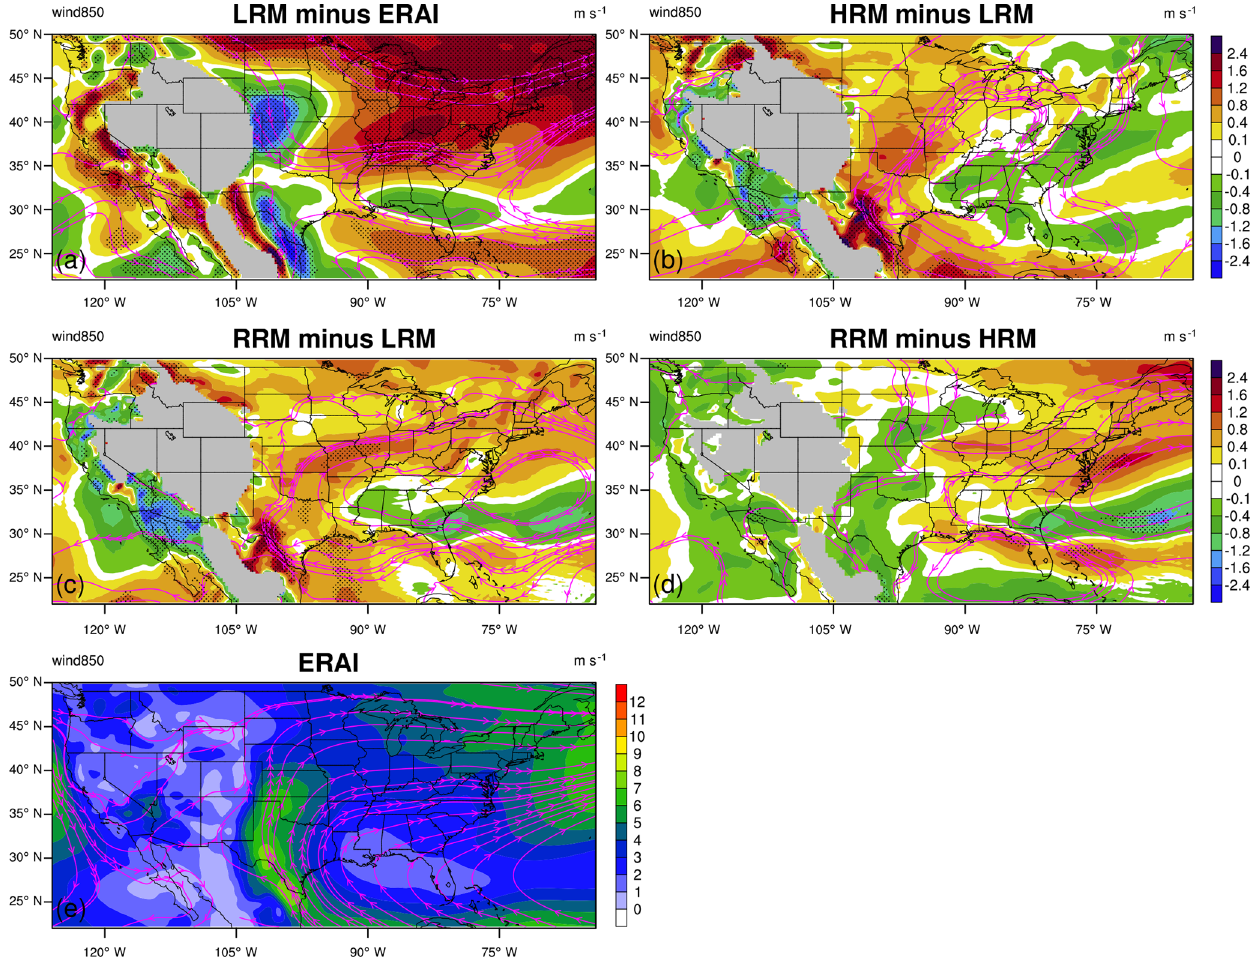
Figure 8. Same as Fig. 4, but for 850hPa wind speed (unit: ms − 1 ) in JJA. The vectors are shown by colors (magnitudes) and magenta streamlines (directions). Grid boxes where surface pressure is less than 850hPa are shaded in gray in the difference